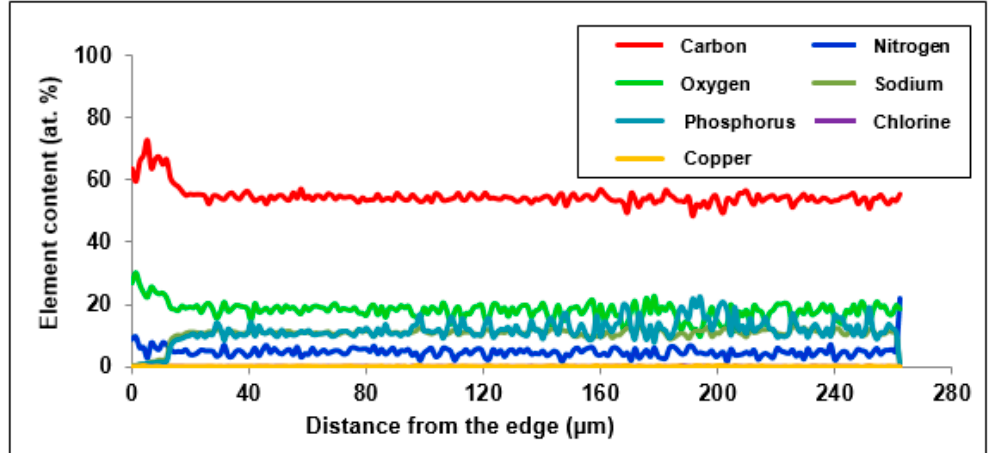
Figure 6. Distribution of the content of elements in the cut beads of Purolite S 940 after the Cu(II) ions sorption.